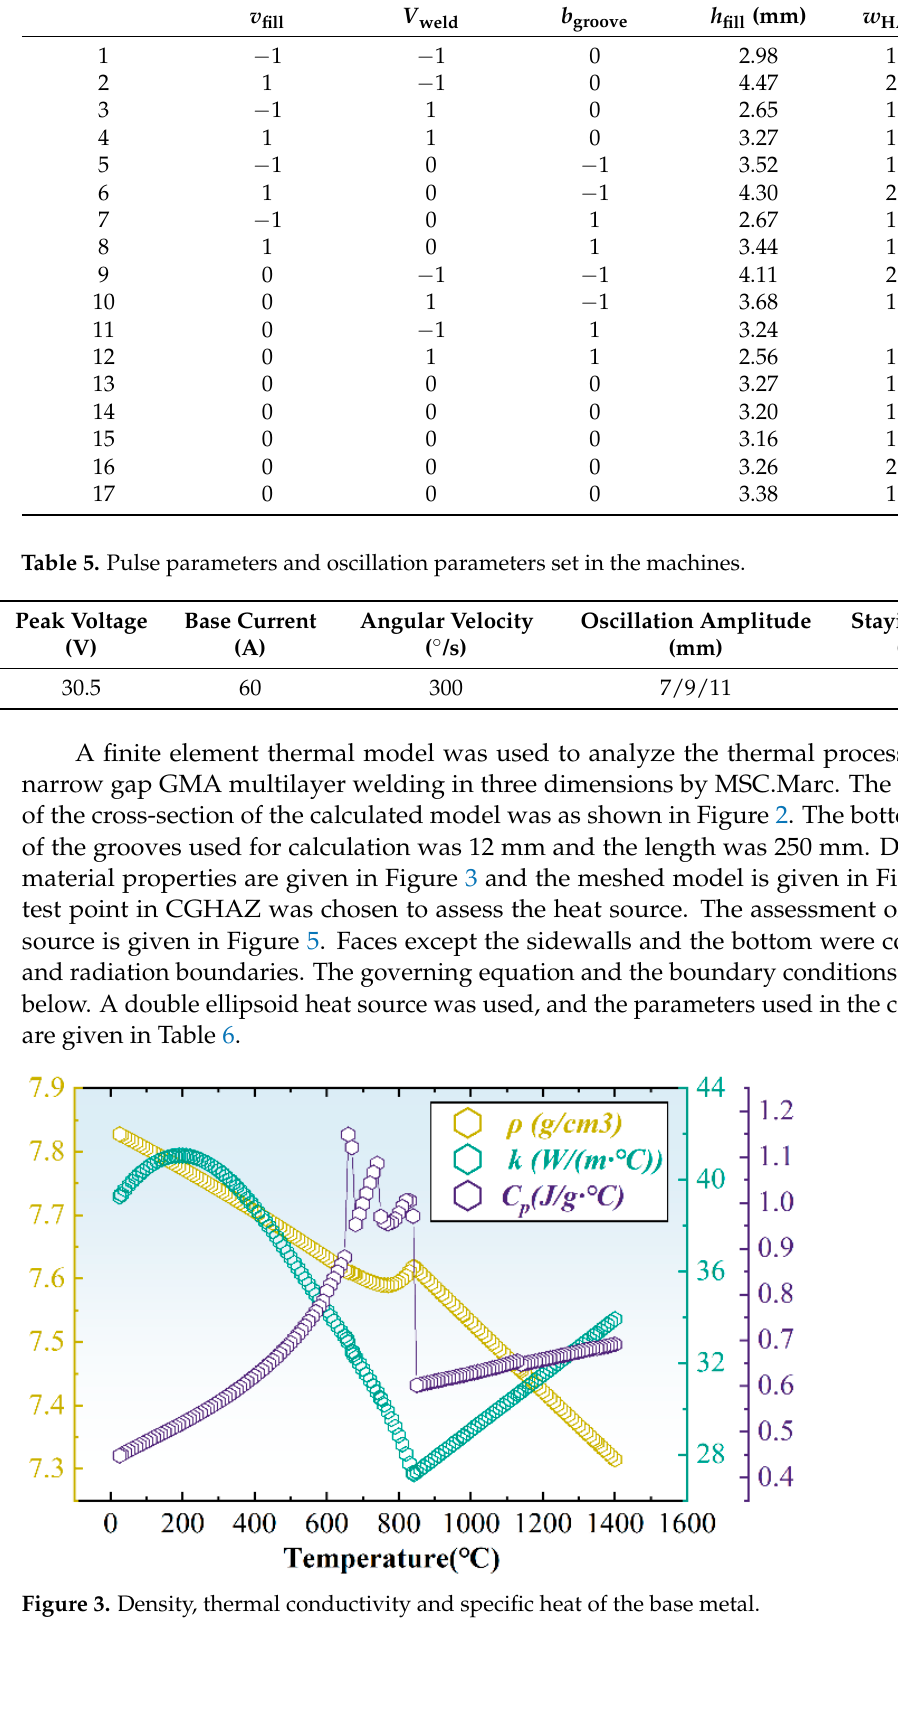
In Equations (1)–(5), ρ is the density of the metal used for calculation, λ is the thermal conductivity with the assumption of material isotropy, h c is the convective heat transfer coefficient, T 0 is the initial temperature, U is the average voltage and I is the average cur- rent.